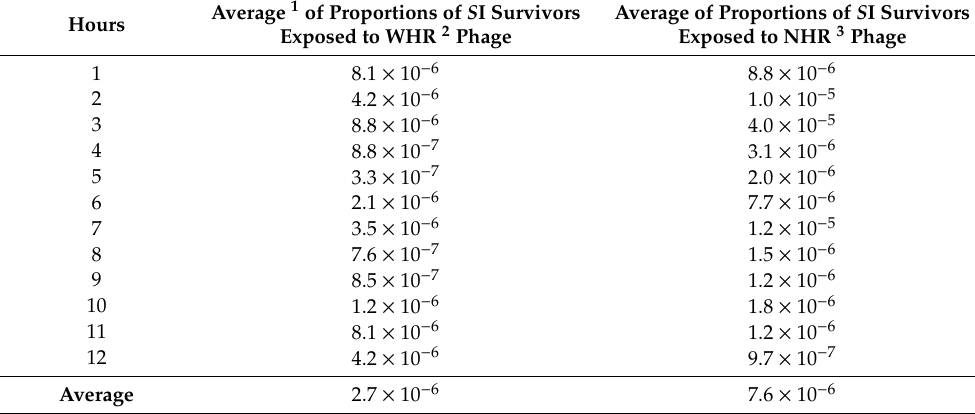
Table 2. Proportion of S. Infantis survivors after exposure to wide- and narrow-host-range phages in the selective challenge